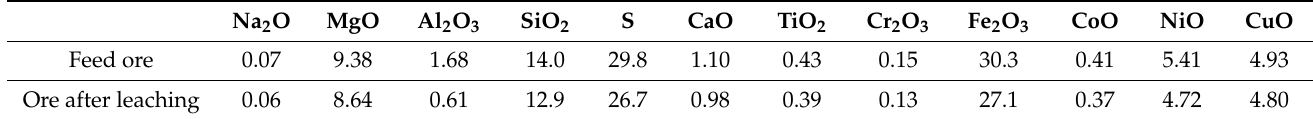
Table 1. Chemical composition of the Allarechensk TD ore.